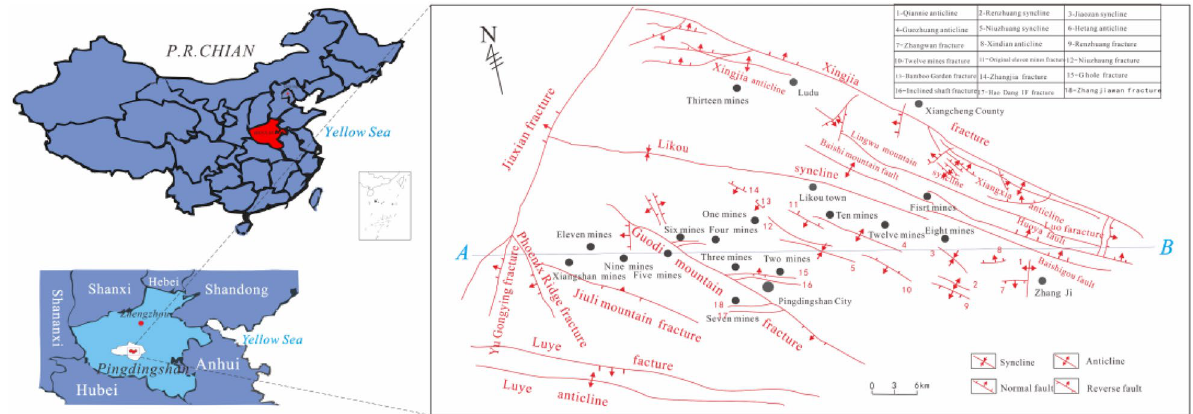
Figure 1. General map of the study area (the figure was drawn by MapGIS 6.7, URL link: https:// www. mapgis. com/ index. php?a= shows & catid= 97& id=